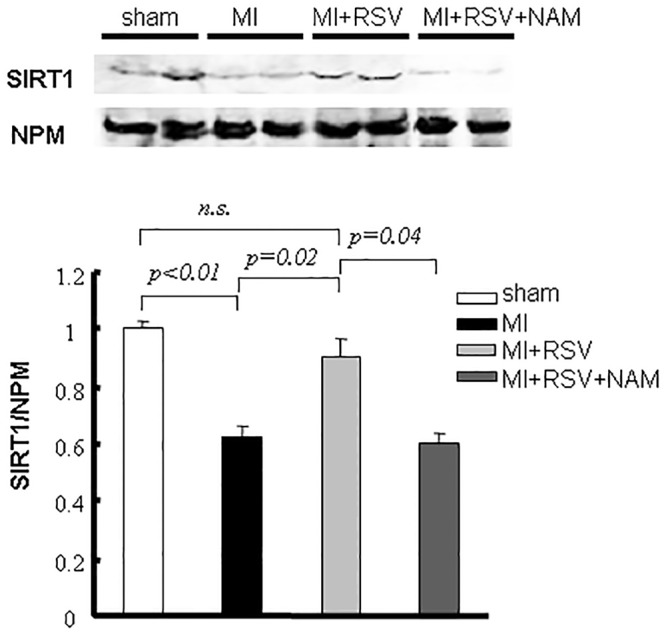
Changes of SIRT1 by MI, RSV and SIRT inhibition.The SIRT1 level in the nuclear extracts (LV) decreased during acute injury. RSV or NAM loading modulated SIRT1 expression in AMI.